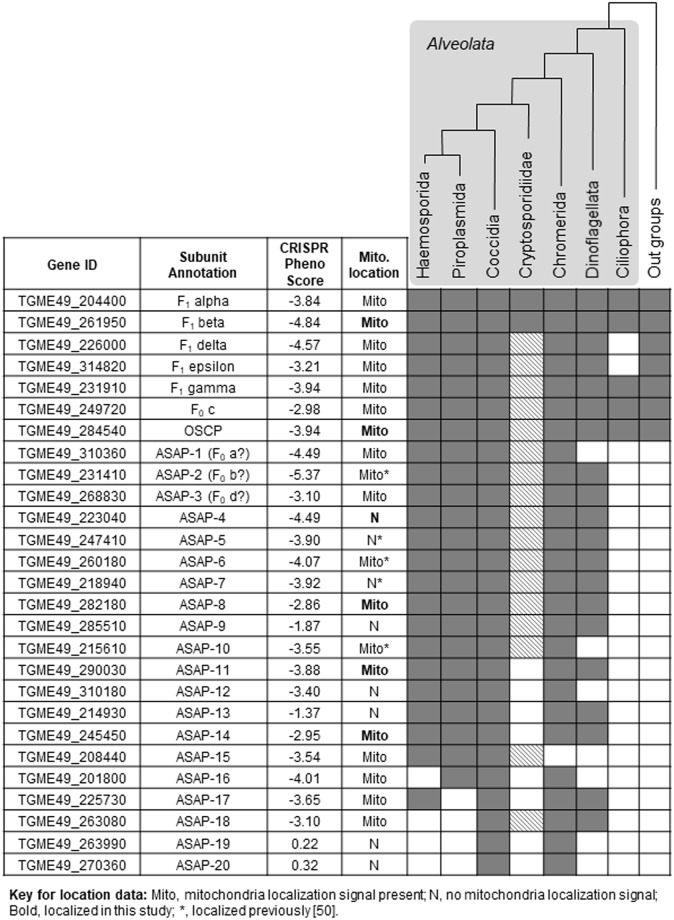
Phylogenetic profile of the alveolate infrakingdom for all T. gondii F-type ATP synthase subunits.Alveolate clades are highlighted with a gray background, and their expected phylogenetic relationship is indicated by a tree structure above. Gray and white boxes indicate the presence and absence of the corresponding ortholog, respectively. The hatched boxes represent the presence of the ortholog in C. muris only and absence in C. parvum and C. hominis. The table on the left lists the gene ID for all ASAPs, along with their annotation, essentiality phenotypes (phenotype score from CRISPR/Cas9 knockout study [50]), and protein localization. The key for localization annotation is given below the table. ASAP, ATP synthase–associated protein; Cas9, CRISPR-associated 9; CRISPR, clustered regularly interspaced short palindromic repeat; OSCP, oligomycin sensitivity–conferring protein.